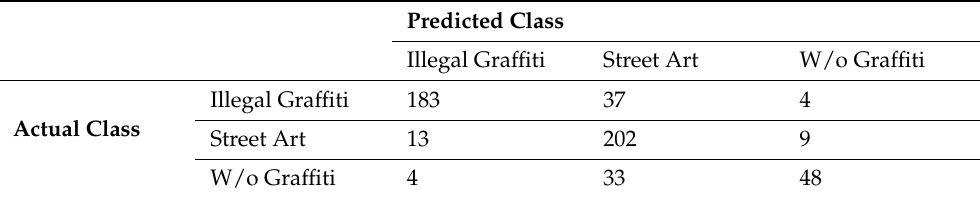
Table 7. Confusion matrix obtained with images from the test set.